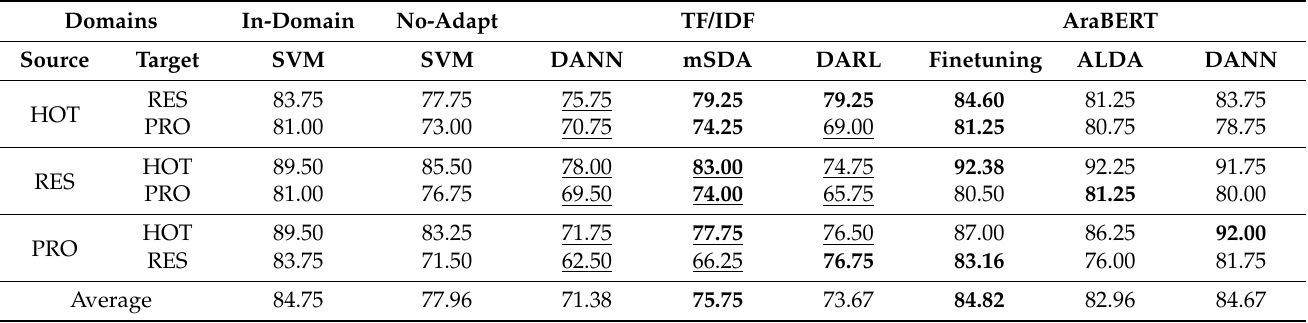
Table 2. The classification accuracy results of in-domain, no adaptation baseline and domain adapta- tion methods on MSA (LAMD